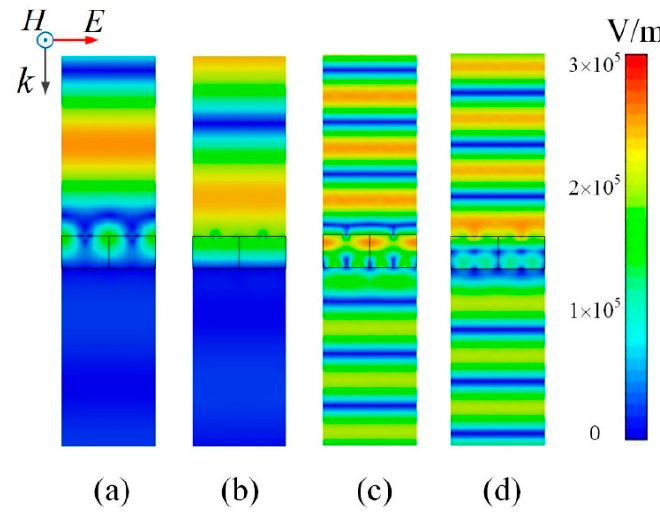
Figure 6. Electric field intensity distributions along the propagation direction when E F = 0.3 eV. ( a ) 0.6 THz, Phase = 0°; ( b ) 0.6 THz, Phase = 90°; ( c ) 1.65 THz, Phase = 0°; ( d ) 1.65 THz, Phase = 90°.